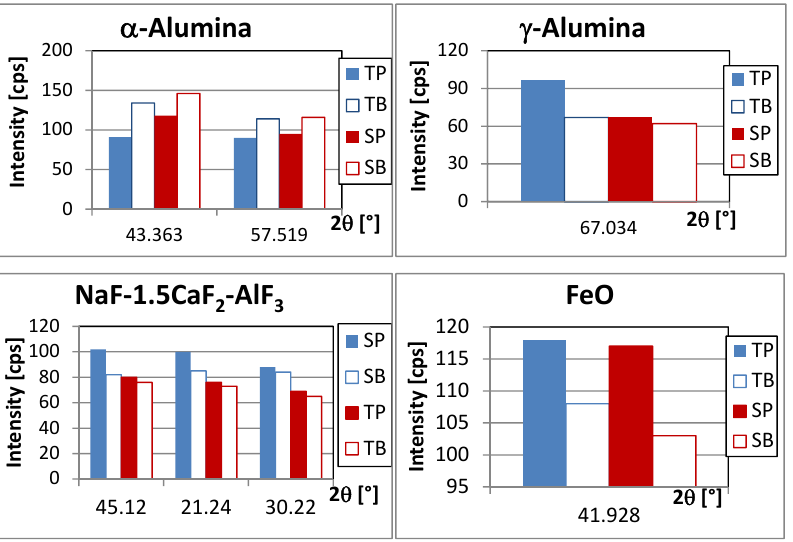
Figure 5. Distribution of the minor components in the frozen bath samples, revealed by XRD.